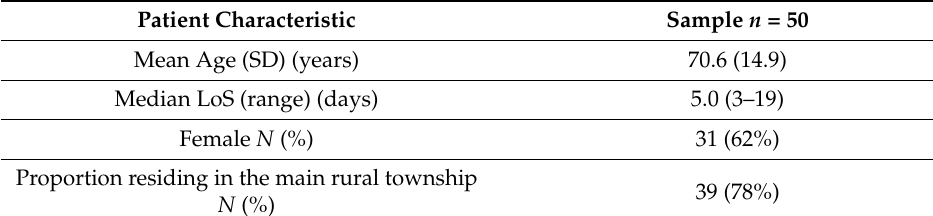
Table 1. Demographics and clinical characteristics of the